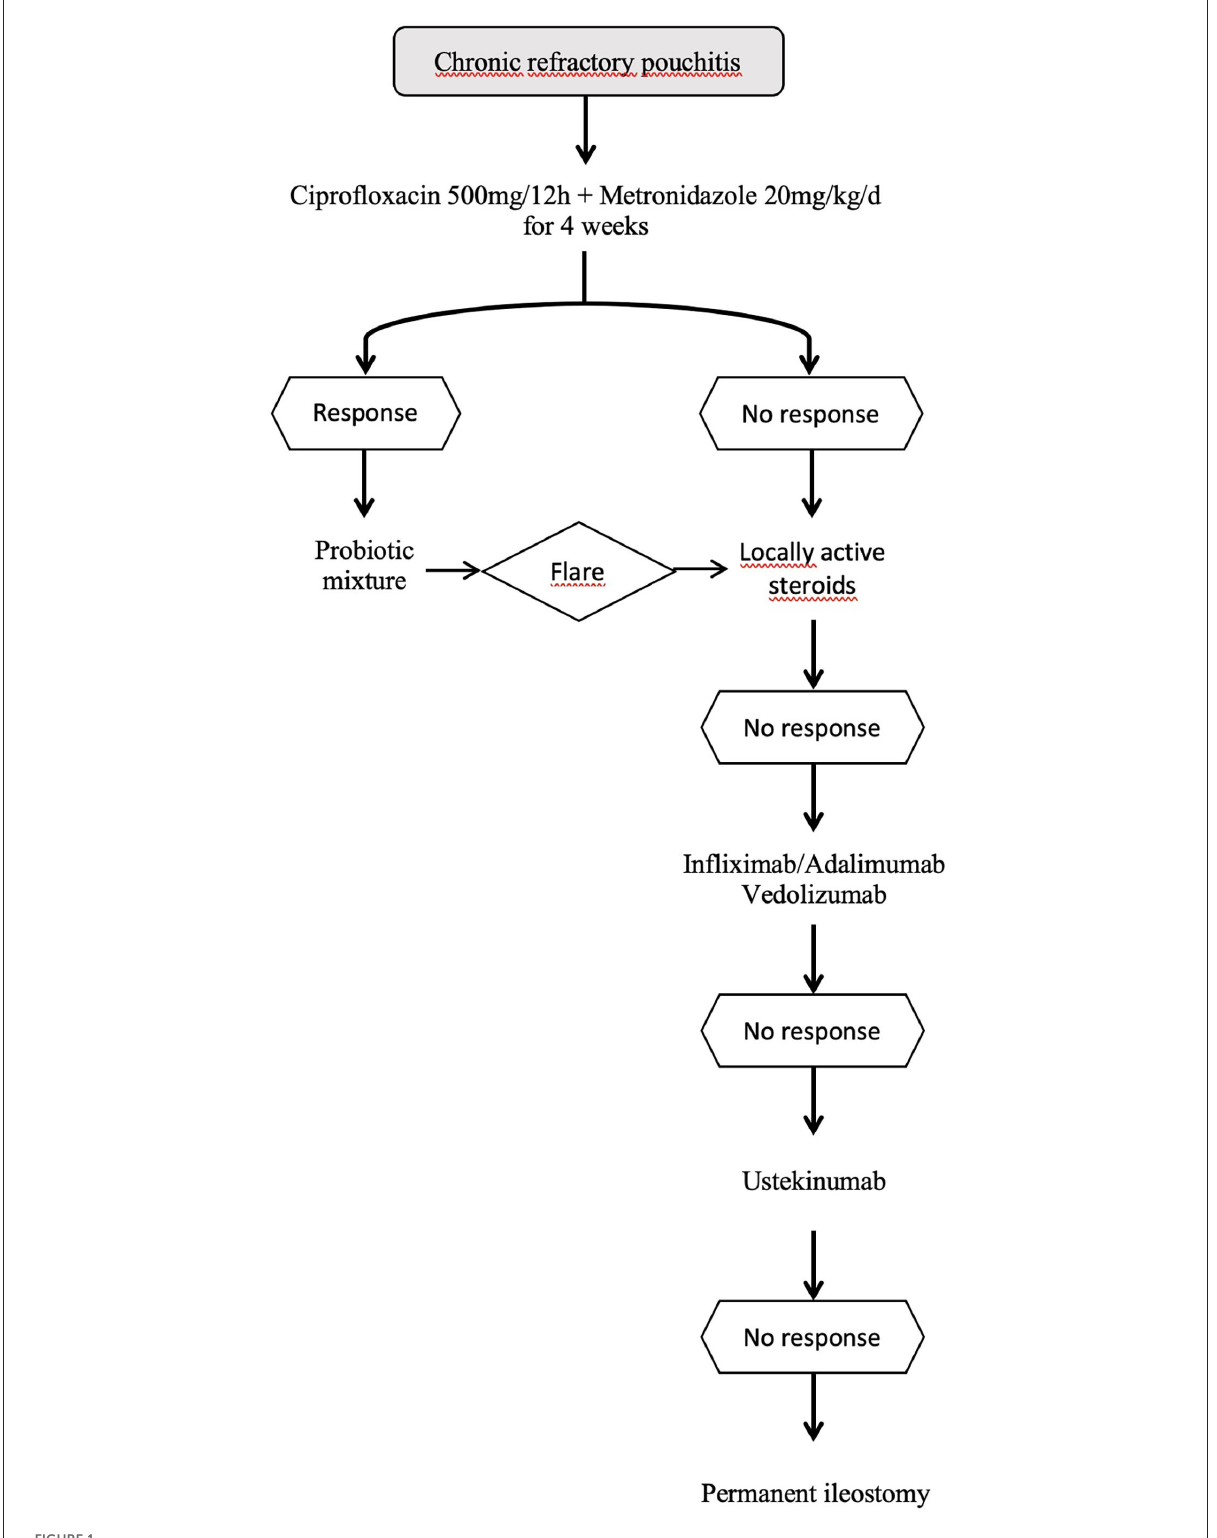
FIGURE1 Algorithm for the treatment of chronic